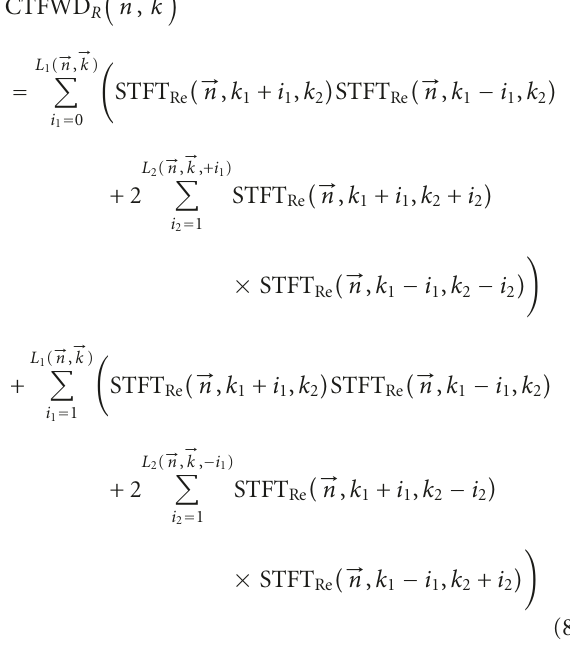
Table 2: Total numbers of complex additions and complex multi- plications, required by the considered S/SFDs, for di ff erent N . (1) 2D SPEC (the proposed method with L 1 (